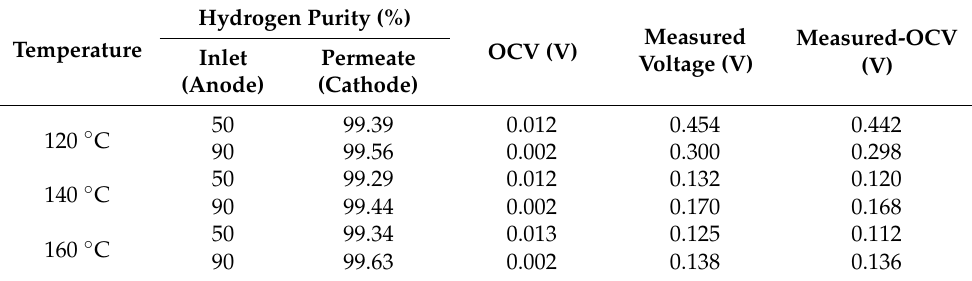
Table 4. Hydrogen purity and cell voltage values as a function of temperature for the H 2 /CO 2 feed mixtures, measured at 0.1 A cm − 2